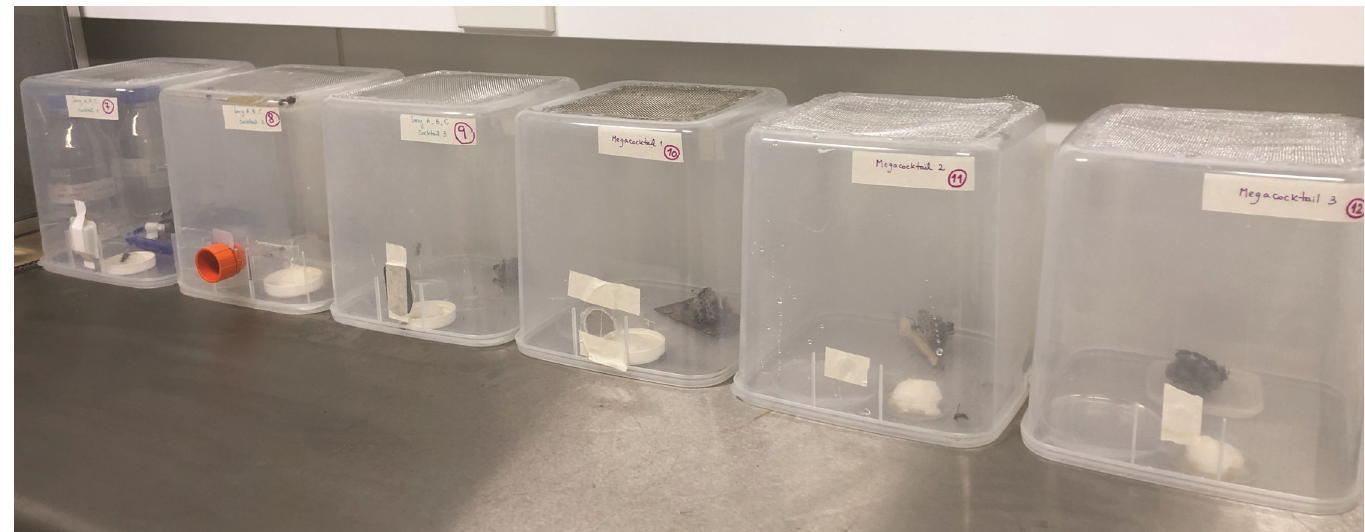
Fig 3. A photograph showing the experimental set up when providing whole colony access to the dsRNA solution. Each cage held one nest, with foragers able to return to their nests and tend for the larvae. Photograph credit: Mariana Bulgarella.